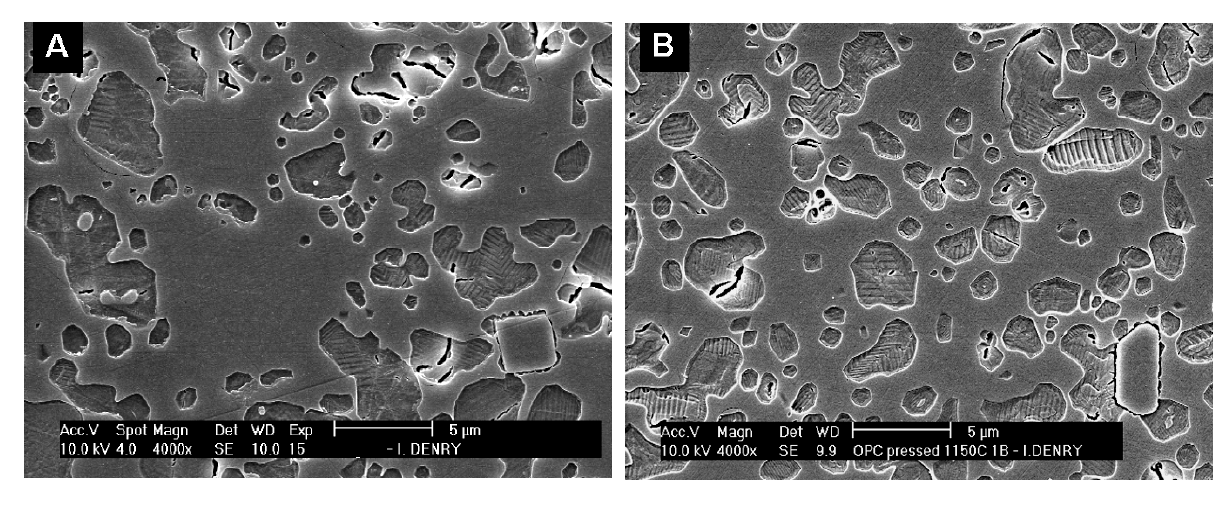
Figure 3. (a) Feldspathic dental porcelain. (b) First generation heat-pressed leucite- reinforced ceramic (3b) Reproduced with permission from